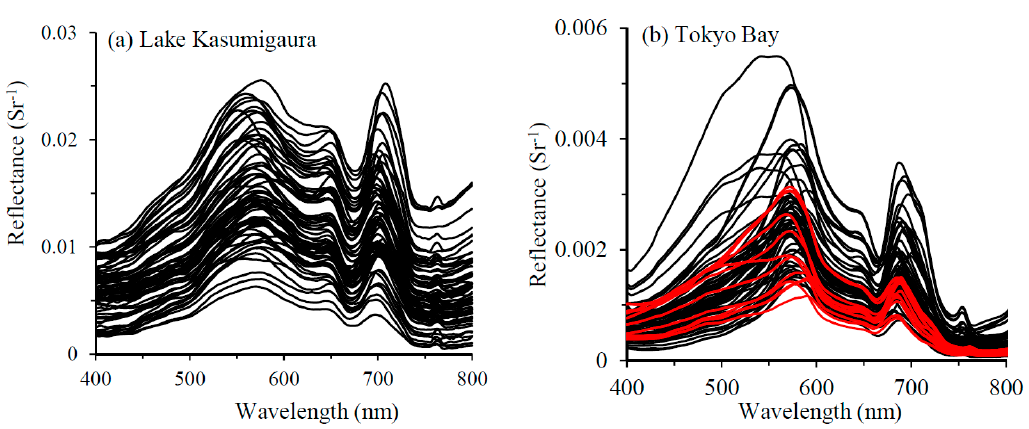
Figure 2. Remote sensing reflectance collected from ( a ) Lake Kasumigaura and ( b ) Tokyo Bay. The red lines highlighted the 12 stations of Tokyo Bay that had additional measurements of absorption and backscattering properties along with remote sensing reflectance measurements. Table 1. Descriptive statistics of the water quality parameters for Tokyo Bay, and Lake Kasumigaura. Tokyo Bay with IOPs (inherent optical properties) dataset refers to stations where additional measurements of absorption and backscattering properties were performed along with remote sensing reflectance measurements. Lake Kasumigaura Datasets 1 and 2 represent measurements collected in 2016 and during 2002–2012, respectively.